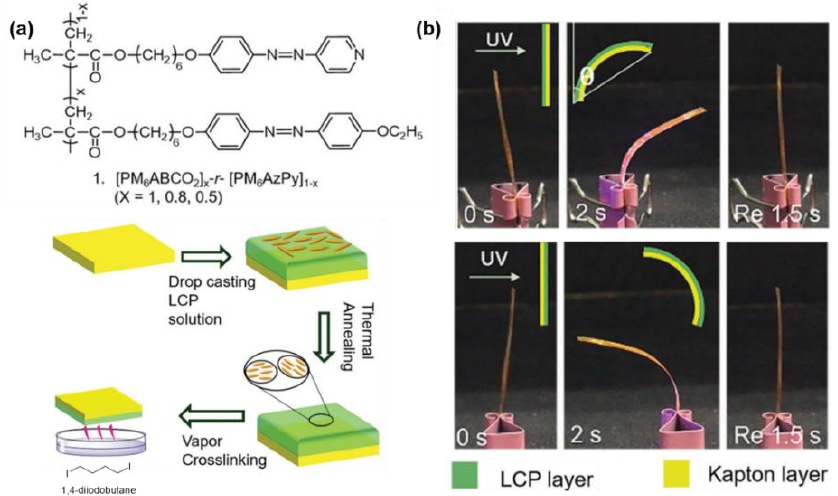
Figure 24. ( a ) Structure of azopyridine containing polymer crosslinked by quaternization reaction of pyridine. ( b ) Photomechanical behaviors of bimorph composites. Reprinted with permission from [123]. Copyright 2019, Royal Society of Chemistry.